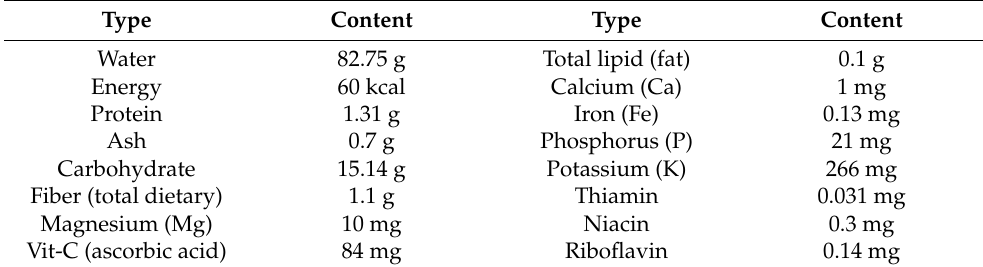
Table 1. Nutritional content per 100 g of fresh D. longan Lour fruit pulp (acquired from the USDA National Nutrient Database [14].